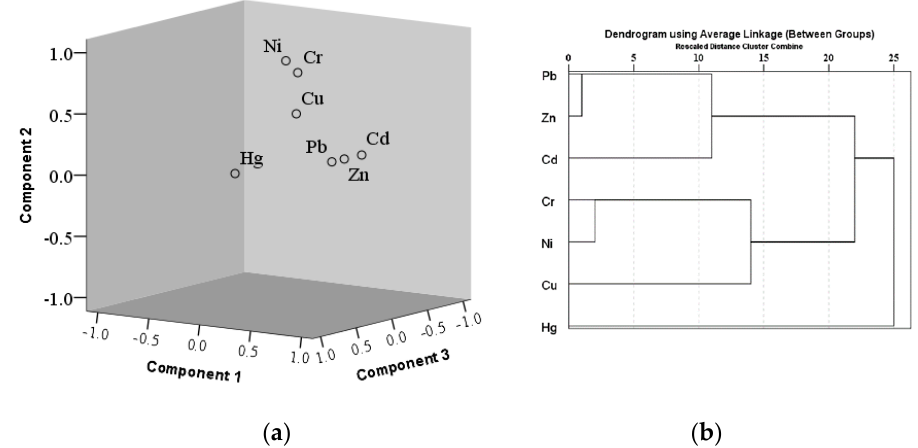
Figure 6. Analysis of seven heavy metals in Shijiazhuang street dust: ( a ) Results from PCA in 3-D space, and ( b ) dendrogram results from applying the Ward method CA.